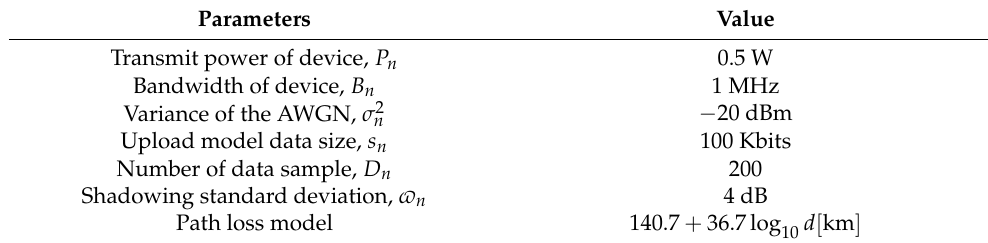
Table 1. Simulation